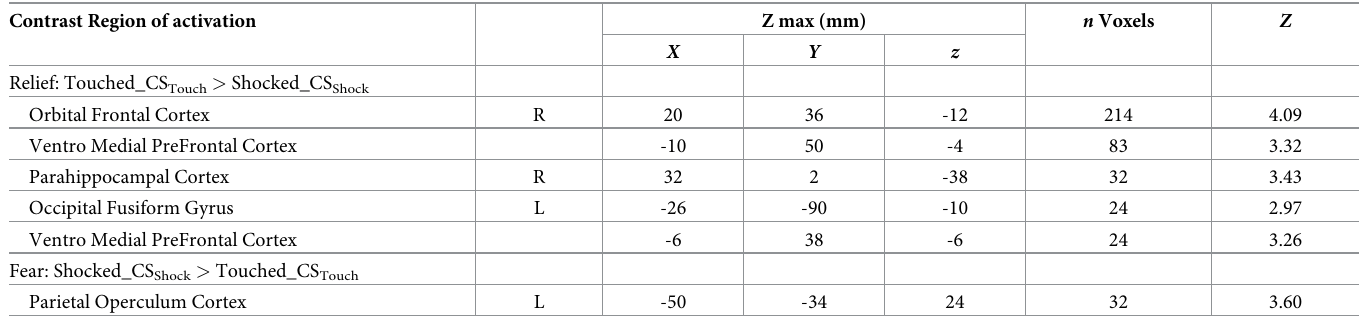
presentation of the CSs (with larger pupil dilation responses for CS indicative of successful fear conditioning, the fact that the pupil responses diminished across the trials in the decision making part of the experiment (Fig 3) may be related to this.